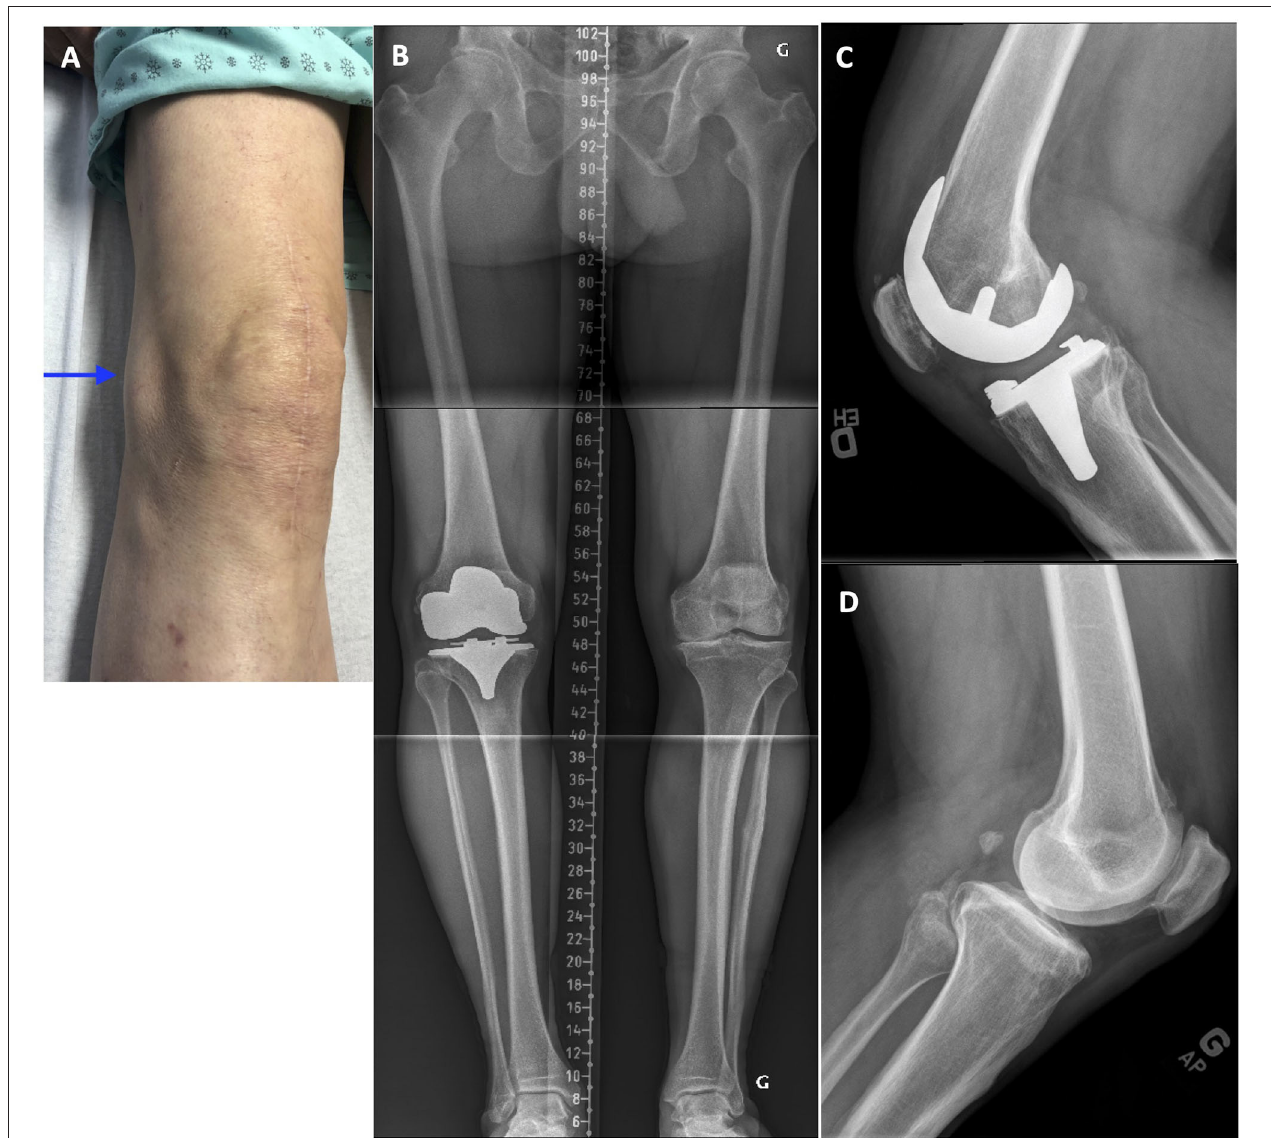
FIGURE 3 | (A) Right knee clinical examination where swelling of the biceps tendon is observed. (B) Pre-revision long leg standing X-Ray reveals a right TKA implant with mDFA of 4 ◦ varus and a mPTA of 1.5 ◦ varus (5.5 ◦ varus aHKA). On the intact left side, the mDFA is 3.0 ◦ valgus and mPTA 3.5 ◦ varus (aHKA of 0.5 ◦ varus). (C) right knee lateral view where the implant posterior tibial slope is 6.5 ◦ . (D) Left knee lateral view where the native tibial slope is 2.0 ◦